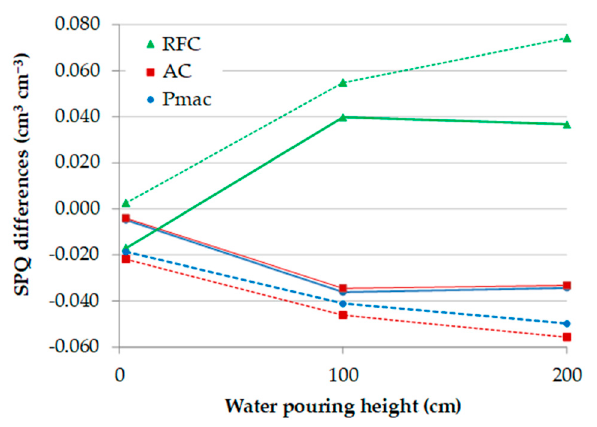
Figure 8. Relative differences in SPQ between measured mean values and the average of the optimal range as a function of heights of water pouring (low, 3 cm; intermediate, 100 cm; high, 200 cm), under minimum and no-tillage (solid and dotted lines, respectively).